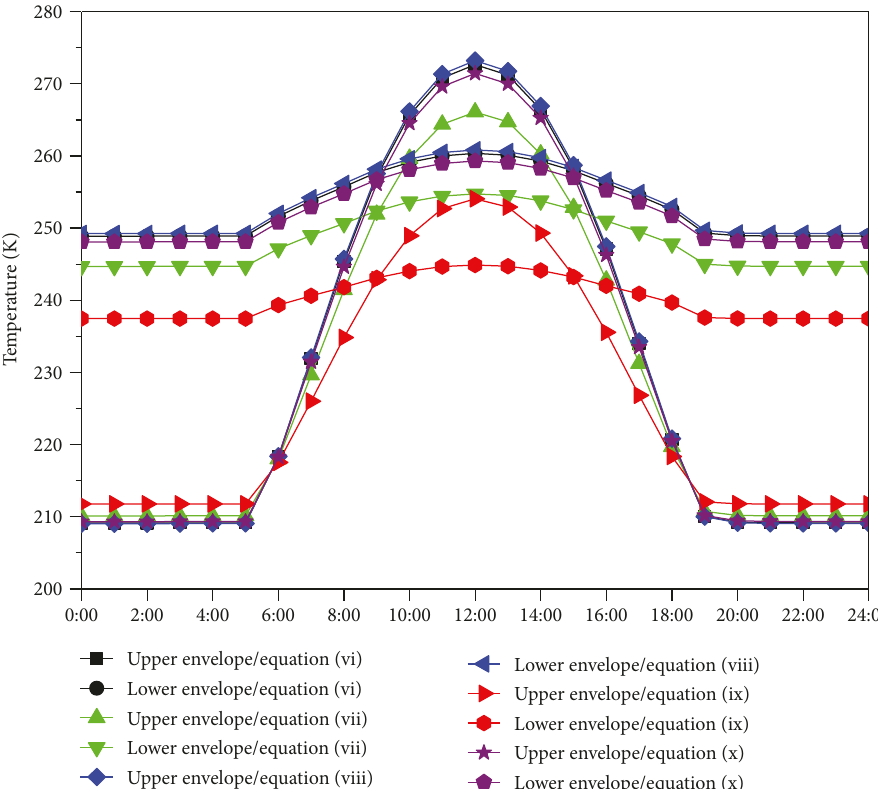
Figure 6: Envelope temperatures calculated by di ff erent forced convection